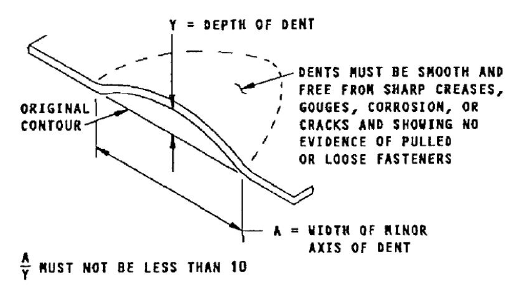
Figure 7. Allowable